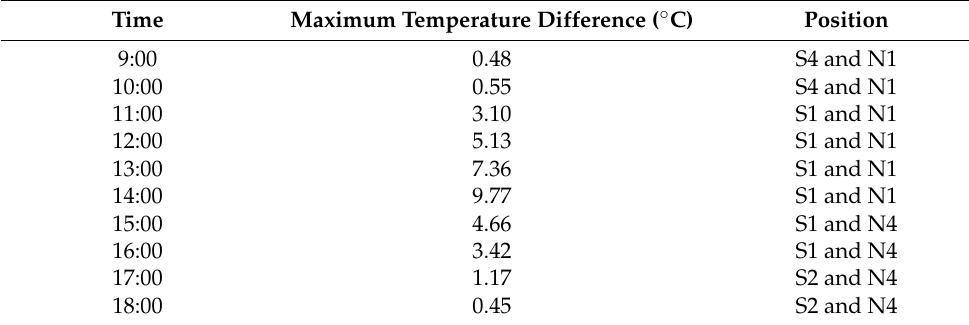
Table 3. Details of measurement